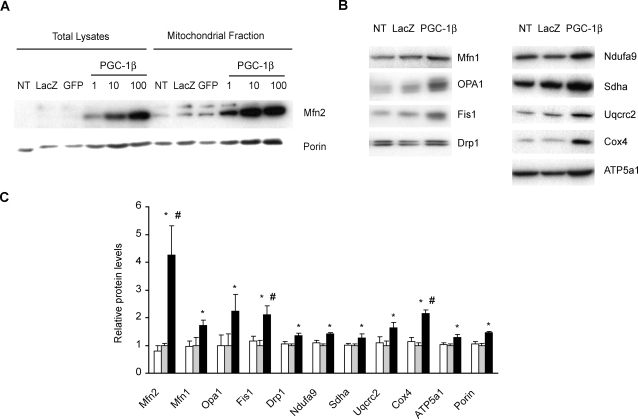
Effect of PGC-1β on the expression of Mfn2, other proteins involved in mitochondrial dynamics, Porin and ETC subunits.Total lysates and mitochondrial fractions were obtained from C2C12 myotubes 48 h after adenoviral transduction, and the expression of proteins was analyzed by Western blot (40 µg). Representative films of a single experiment from four independent differentiation and transduction experiments are shown. (A) Total lysates and mitochondrial fractions of non-transduced myotubes (NT), transduced with LacZ or GFP control adenovirus at a MOI 100 (control adenovirus at a MOI 1 and 10 displayed no changes, data not shown) or with PGC-1β adenovirus at a MOI 1, 10 or 100 were probed with anti-Mfn2 and Porin antibodies. (B) Specific antibodies were used to detect mitochondrial dynamics proteins (Mfn1,OPA1, Drp1 and Fis1) and single subunits from each complex of the ETC (complex I, Ndufa9; complex II, Sdha; complex III, Uqcrc2; complex IV, Cox4 and complex V, ATP5a1) in mitochondrial fractions of non-transduced (NT) or transduced C2C12 myotubes at a MOI 100 with LacZ or PGC-1β adenovirus. (C) Quantification analysis of protein levels of mitochondrial dynamics components and the ETC subunits from complexes I to V detected by Western blot. Mean±SEM of Non- (white bars) , LacZ- (grey bars) or PGC-1β- (black bars) transduced C2C12 myotubes from n = 4 independent differentiation and transduction (MOI 100) experiments. *, statistical difference compared to LacZ transduction, p<0.05. #, statistical difference compared to Porin induction, p<0.05.